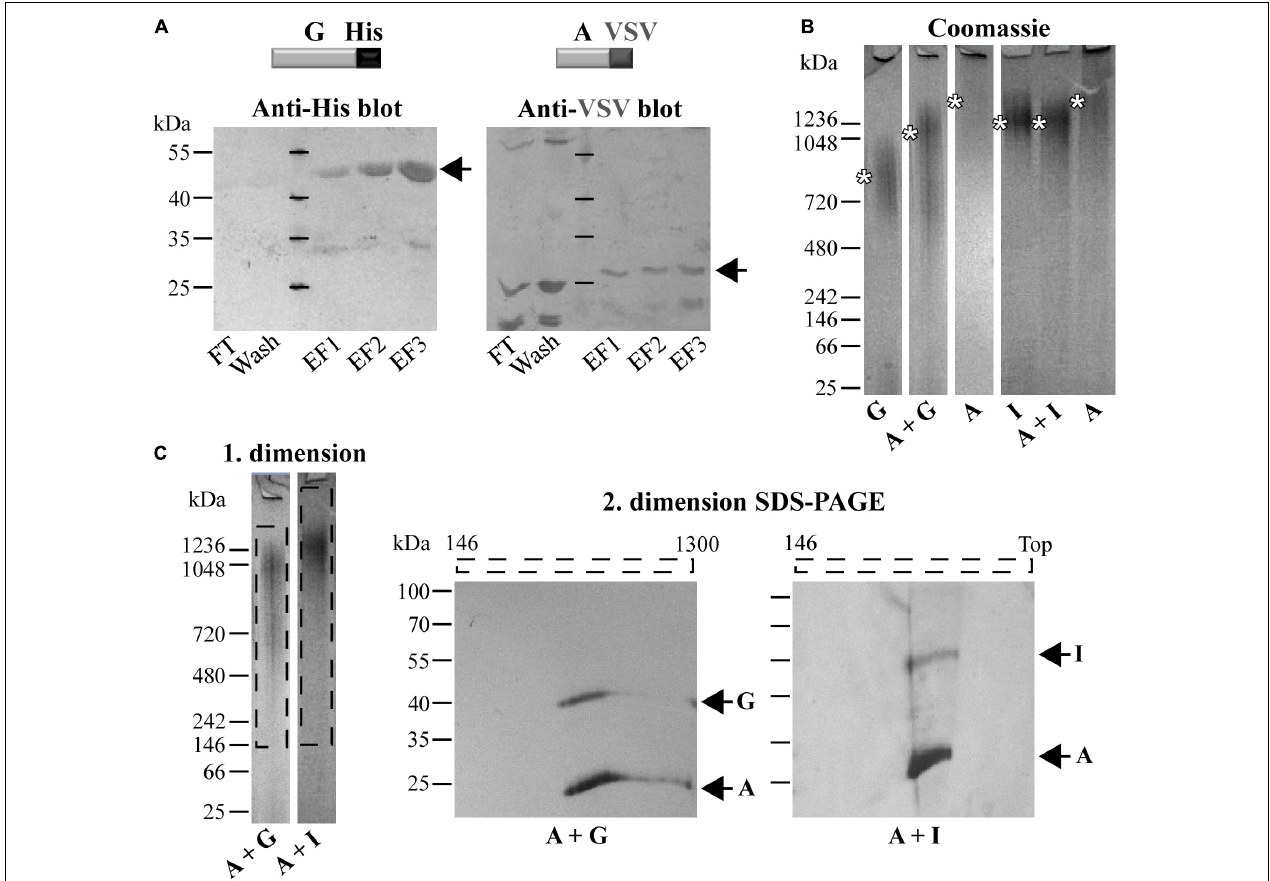
FIGURE 2 | Different co-refolded Pmps form heteromeric hMW complexes. (A) Representative anti-His and anti-VSV immunoblots of pull-down assays of VSV-tagged PmpA (A-VSV) with His-tagged PmpG. FT, Flow Through; EF, Elution Fraction. (B) Representative coomassie-stained Blue Native-PAGE (BN) loaded with 1 µ g of homomeric complexes (A, G, and I) and 1:1 co-refolded heteromeric complexes (A + G and A + I). Asterisks indicate the main bands. BN bands are cut for clarity purposes. (C) Representative 1. dimension BN bands containing the hMW A + G and A + I complexes (dashed box) analyzed by 2. dimension SDS-PAGE. Arrows indicate Pmp proteins. All images are representative of three separate